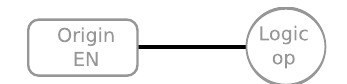
Figure 2.30: The Entity Relationship glyph for logic arc .